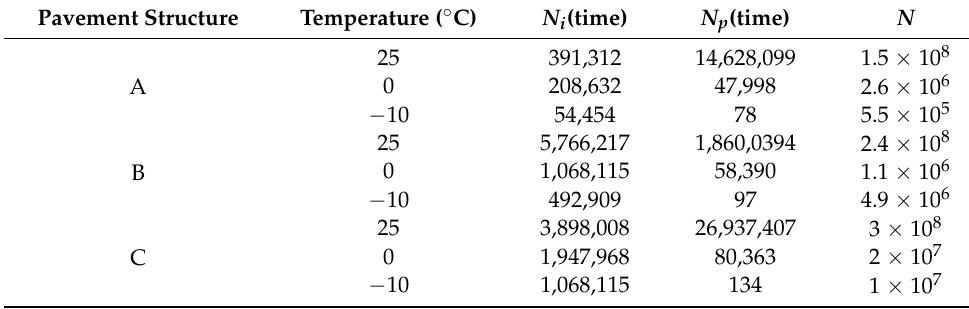
Table 11. Entire fatigue crack life of flexible base asphalt pavement surface. Pavement Structure